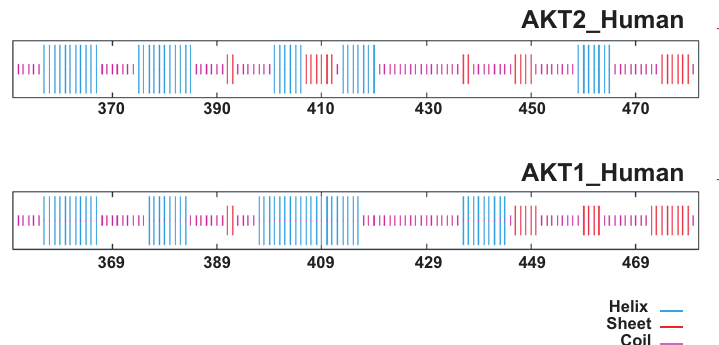
Figure S1 Schematic representing the Akt2 truncated proteins. This figure represents a schematic view of Akt2 full- length (1–481) as well as N-terminal and C-terminal Akt2 truncated proteins used for immunoprecipitation, pull down and cell transfection experiments.